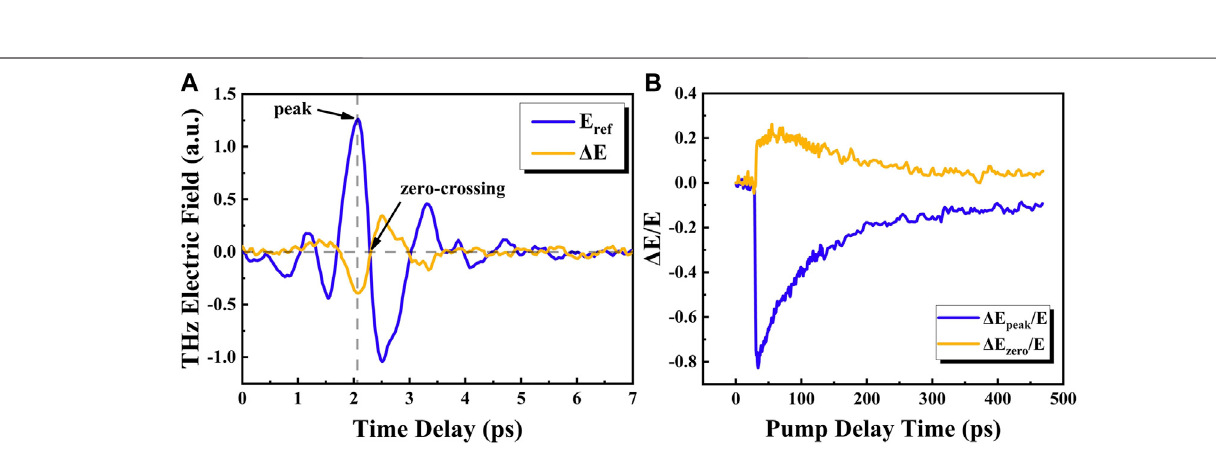
FIGURE2|(A) TransmittedTHzelectric fi eldE(t)(blueline)andphoto-inducedchangeoftheTHzwaveformatpumpdelaytime Δ E(t pump (cid:2) 20 ps)(yellowline)with the pump power of 20 mW for the MoS 2 crystal. (B) Pump-induced changes of the THz amplitude and phase of layered MoS 2 crystal at the peak and zero-crossing positions of the THz